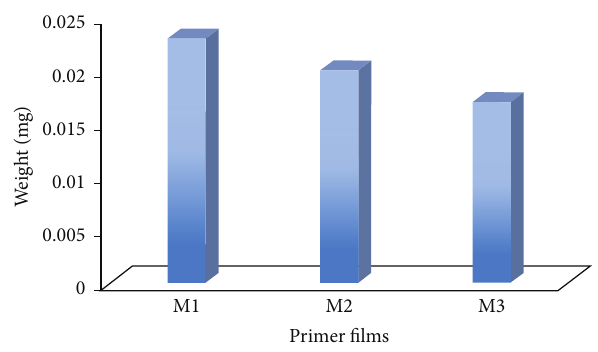
Figure 9: Water absorption test of primer films M1, M2, and M3.